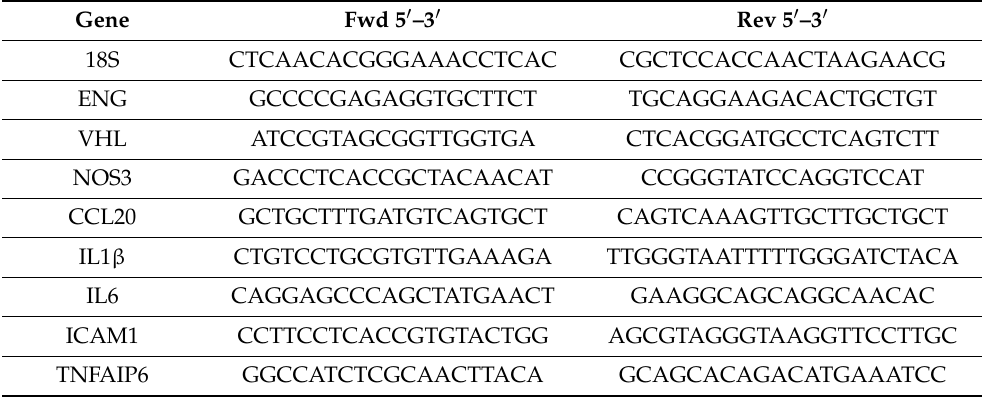
Table 1. Primers used for q-PCR